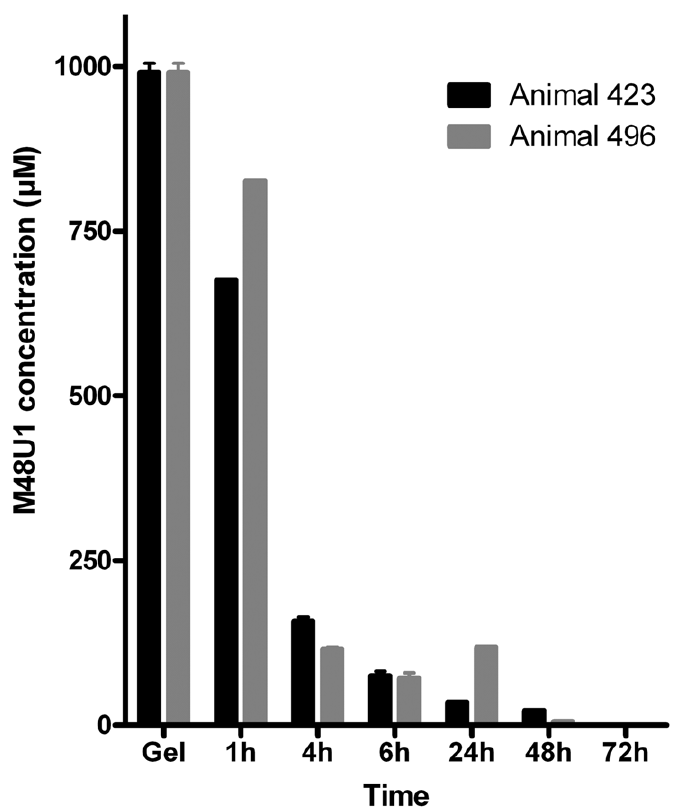
Figure 3. Pharmacokinetic studies in non-infected macaques. Mean concentration of M48U1 miniCD4 measured in the vaginal fluid of two cynomolgus macaques following vaginal administration of a single 2 g sample of 1.5% hydroxyethylcellulose (HEC) gel containing M48U1 at 3 mg/g (about 1 mM). The vaginal fluids were sampled before and 1 h, 4 h, 6 h, 24 h, 48 h and 72 h after gel application and analyzed by MS spectra with an internal reference for M48U1 quantification. The bars represent the standard error of the mean (SEM) of the three assay